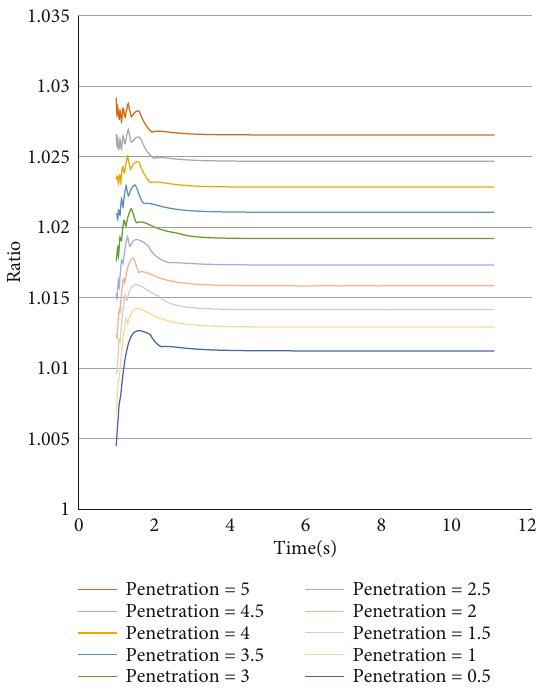
Figure 9: Ratios of force (where v (substrate) equals 0.5) to force (where v (substrate) equals 0.25) as a function of displacement, when E and g of the substrate equals 1.4GPa and 0.9, respectively. i